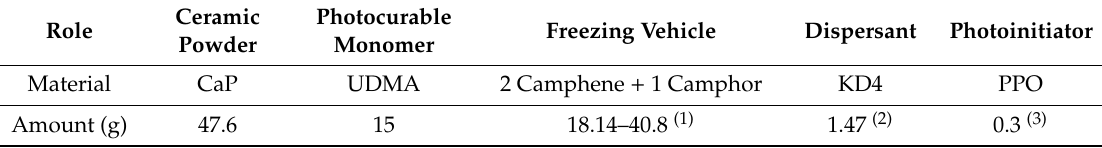
Table 1. Compositions of CaP ceramic suspensions used for the digital light processing (DLP) process.